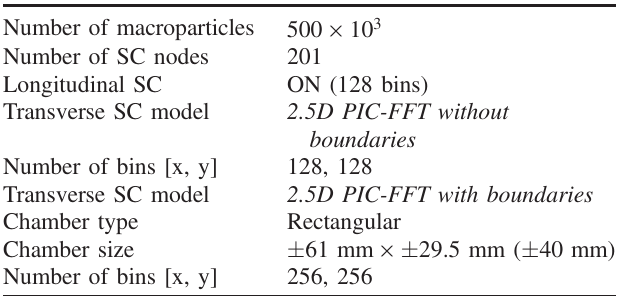
TABLE IV. Simulation settings for the dynamic integer case (with and without boundaries).